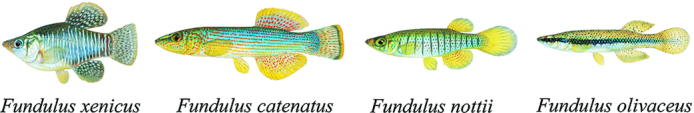
Four Fundulus killifish (left to right): the marine diamond killifish, Fundulus xenicus; the freshwater northern studfish, Fundulus catenatus (south central United States); the freshwater bayou topminnow, Fundulus nottii; and the freshwater blackspotted topminnow, Fundulus olivaceus. (drawings used with permission from the artist, Joseph R. Tomelleri).